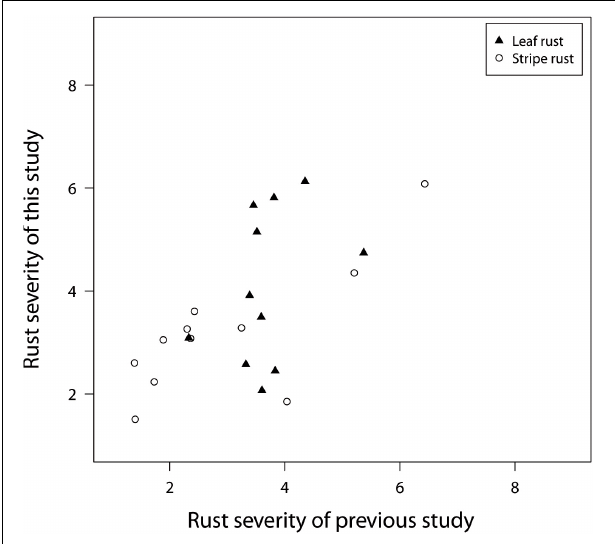
FIGURE 3 | BLUEs representing leaf rust and stripe rust resistance of 11 check varieties, used in field trials of a previous study realized during field seasons in 2016 and 2017 in comparison to the field trial of 2018 belonging to this study.